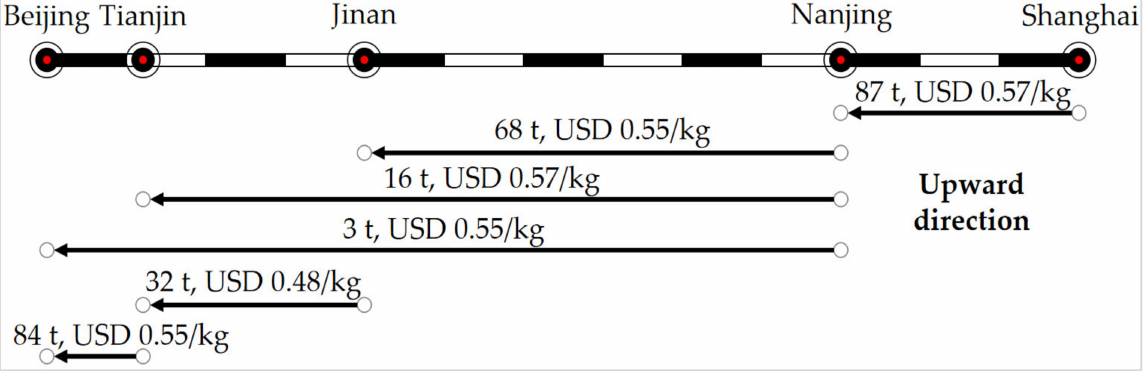
Figure 3. The solution results of the upward